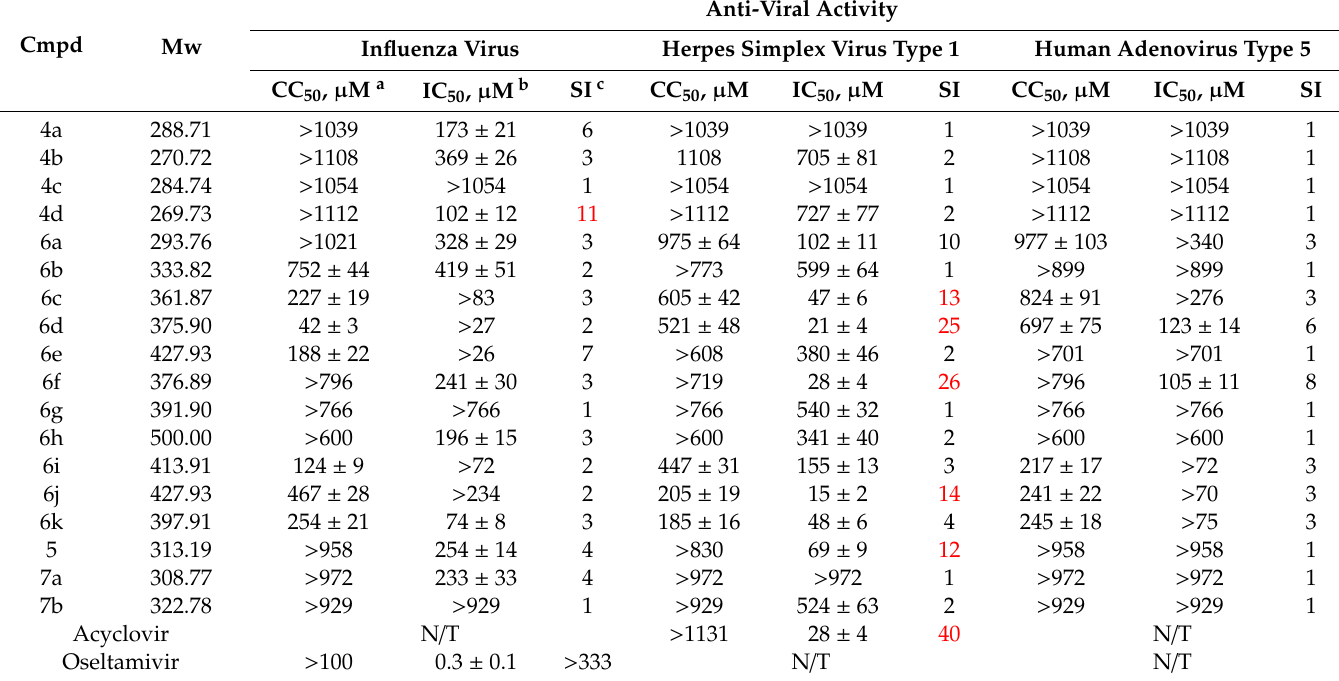
Table 2. Cytotoxic and virus-inhibiting properties of 1 (cid:48) -homocarbanucleosides analogs against influenza virus, human herpesvirus type 1 and human adenovirus type 5 in cell culture. Values of selectivity indices 10 and higher are marked by